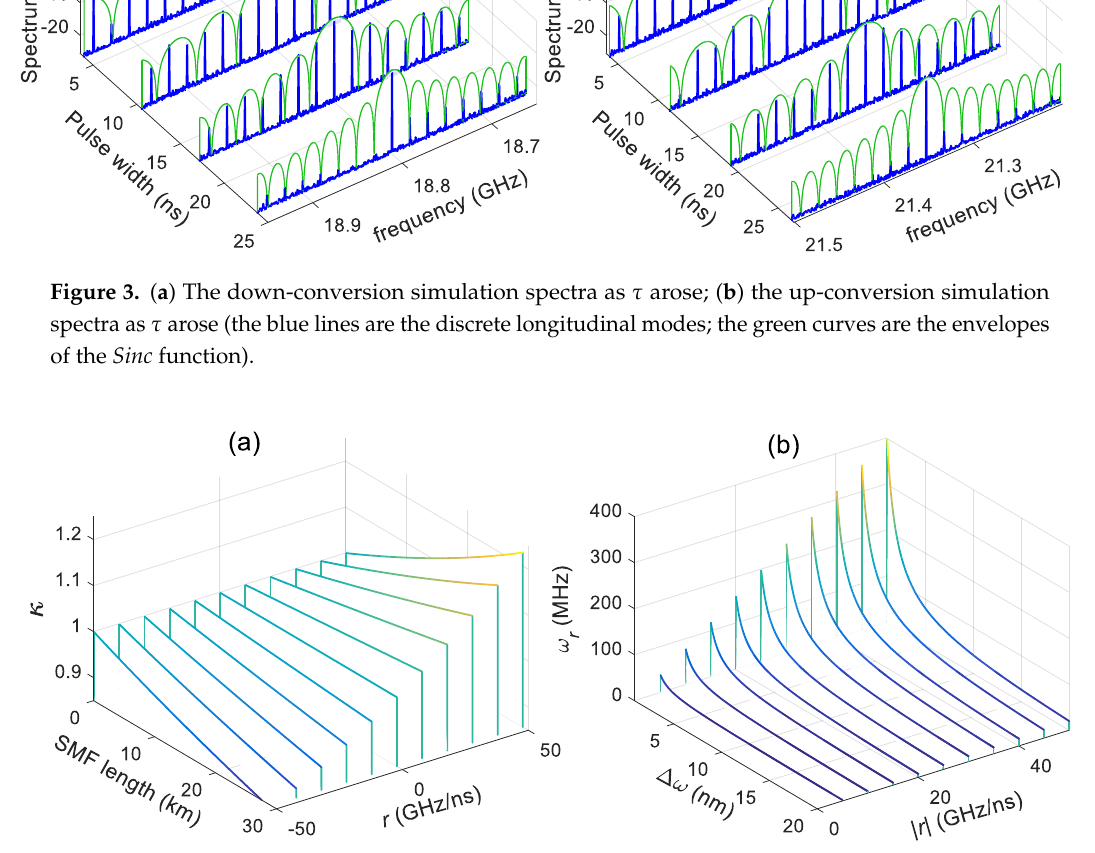
Figure 3. ( a ) The down-conversion simulation spectra as τ arose; ( b ) the up-conversion simulation spectra as τ arose (the blue lines are the discrete longitudinal modes; the green curves are the envelopes of the Sinc function).